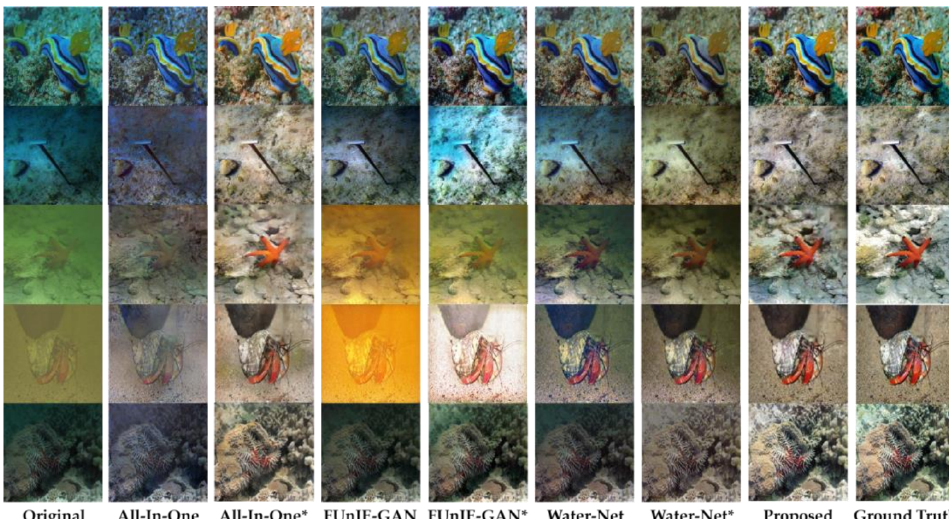
Figure 8. Qualitative evaluation on simulated underwater images. From left to right are original underwater images, enhanced images produced by each network entity, and the corresponding ground-truth